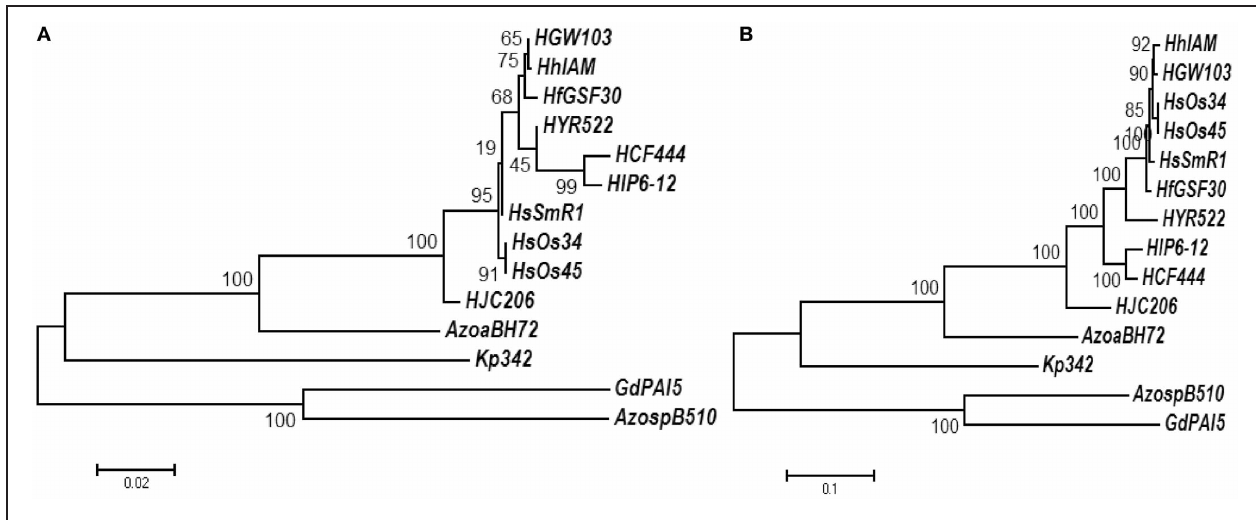
FIGURE 1 | Phylogenetic relationship based on 16S rRNA sequences (A) and marker proteins (B). HfGSF30 and other Herbaspririllum strains and diverse endophytes. The scale bar represents 2% (A) or 10% (B) sequence divergence and numbers on the tree represent bootstrap values. HsSmR1